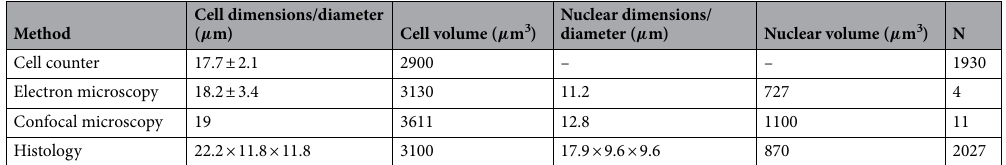
Table 2. Dimensions and volumes for cellular